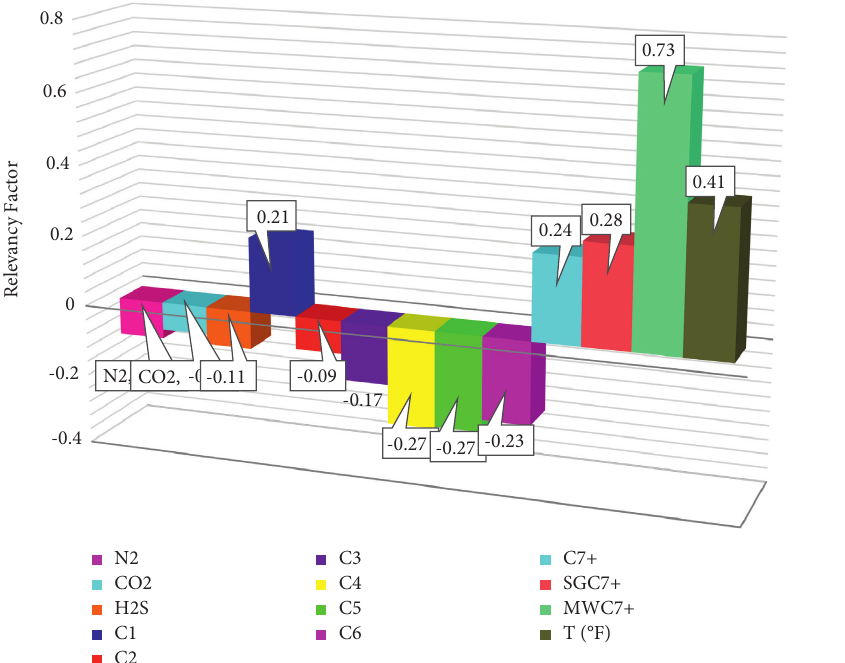
Figure 5: Sensitivity analysis on input parameters affecting the output target